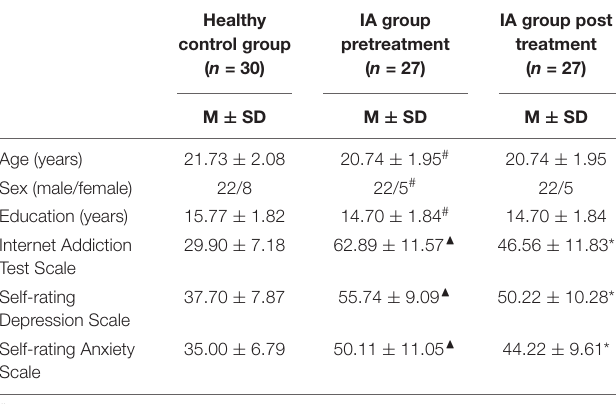
TABLE 1 | Demographic characteristics and treatment response.